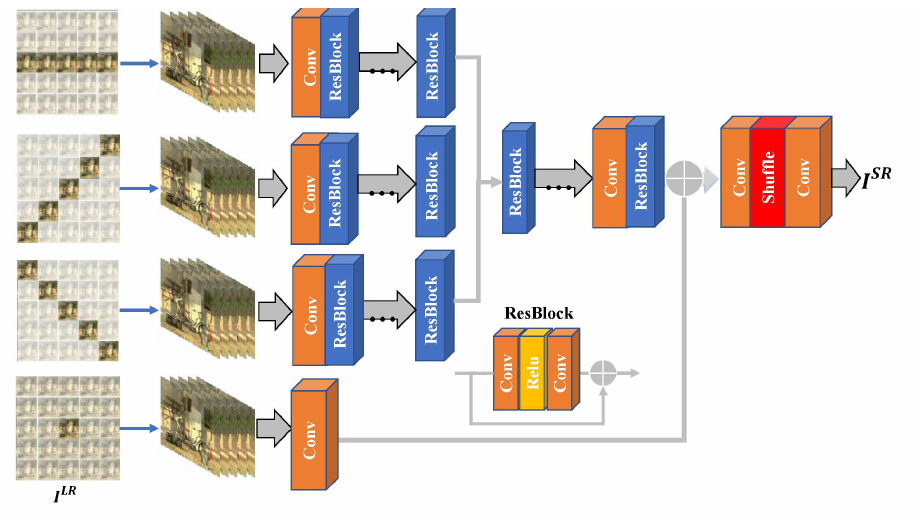
Figure 8. Network structure proposed by Zhang [24].